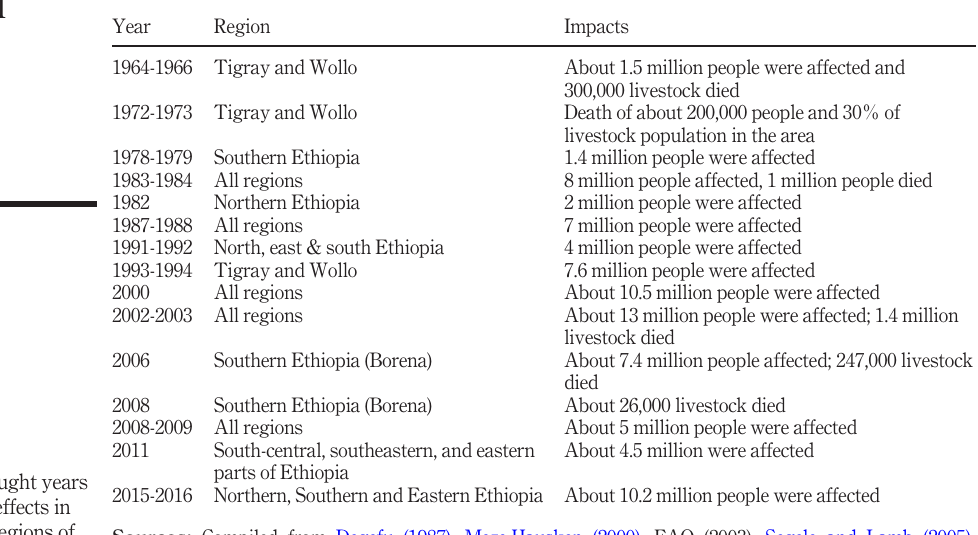
and their effects in different regions of ethiopia for the